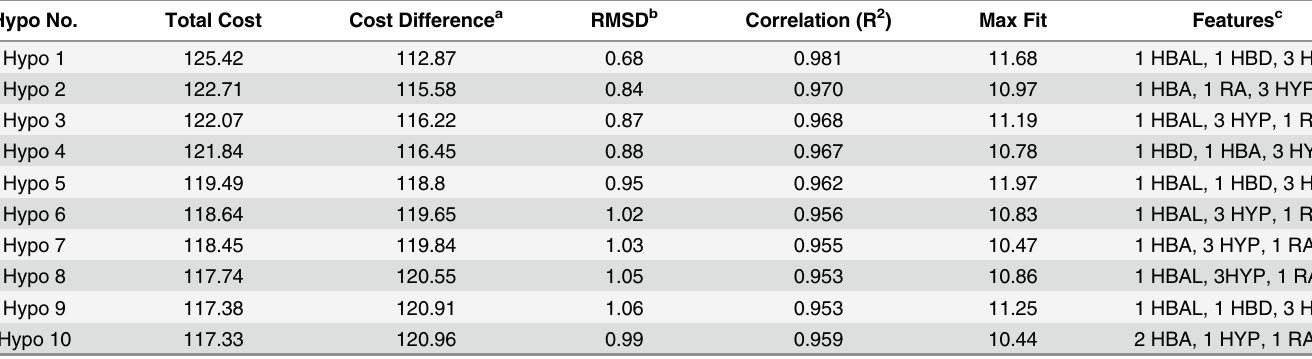
a Cost difference, difference between the null cost and the total cost. The null cost of ten scored hypotheses is 238.29, the fi xed cost value is 106.43. All costs are represented in bit units.